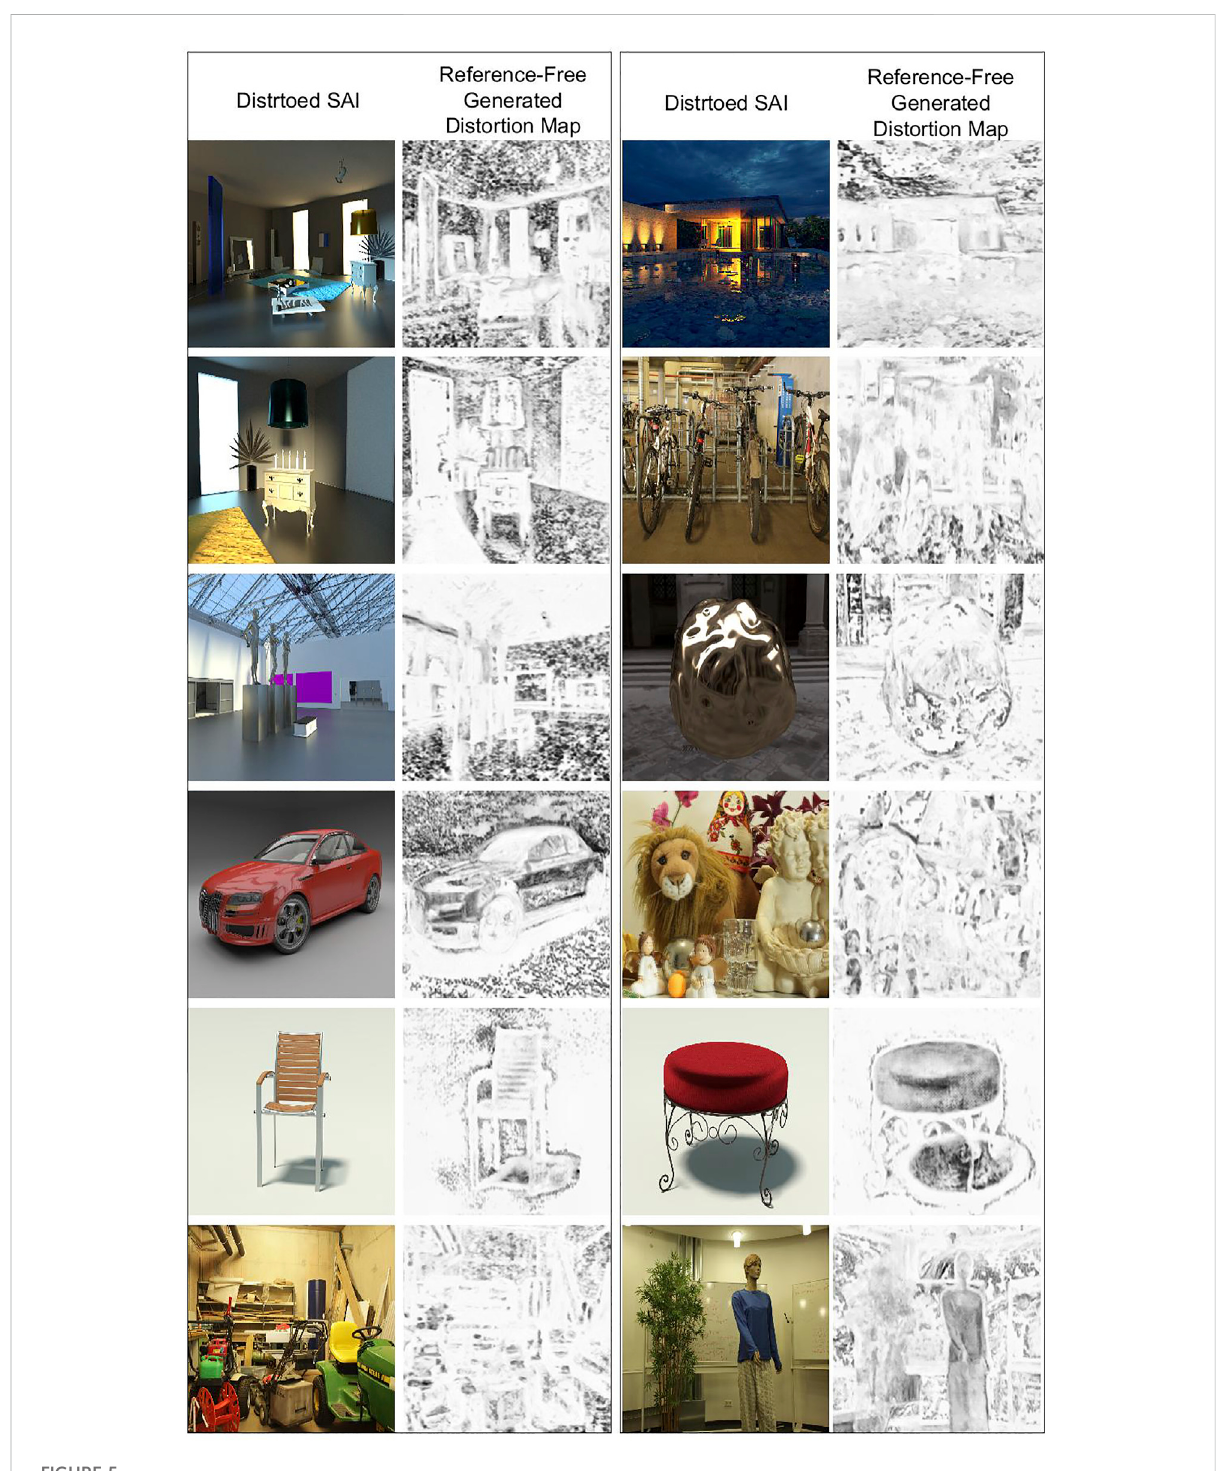
FIGURE 5 Examples of generated distortion maps of central SAIs of different test LFIs from MPI dataset (Adhikarla et al.,